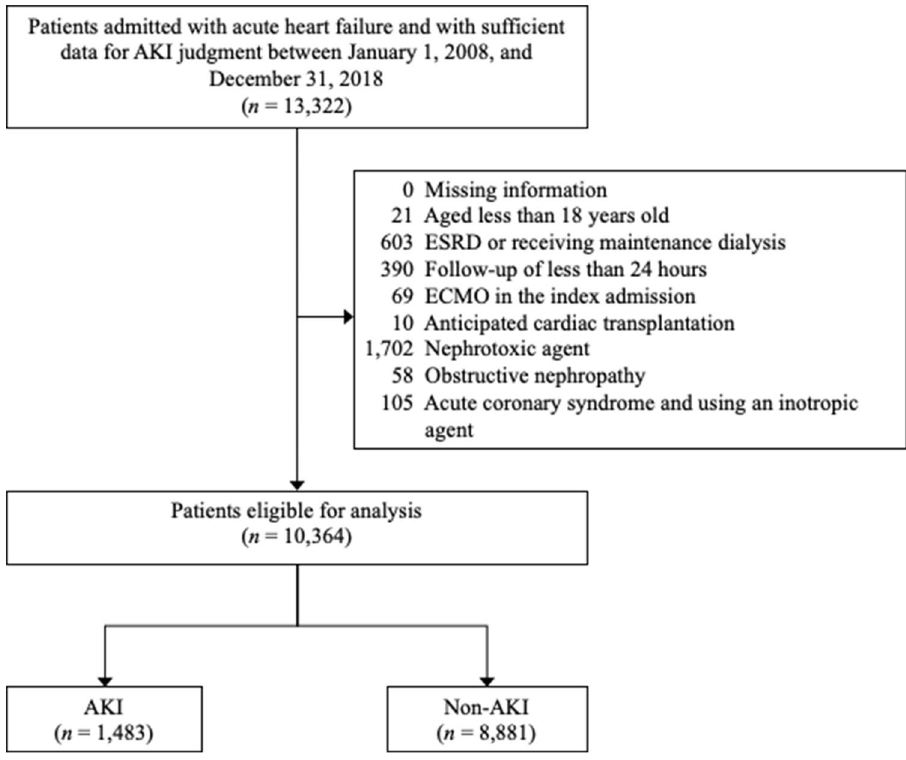
Figure 1. Flow chart for patient selection.